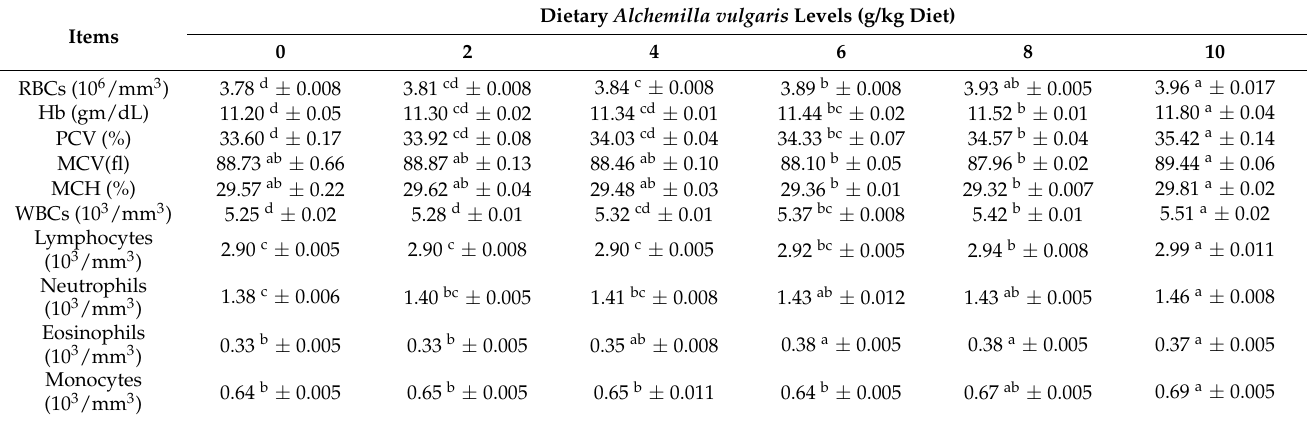
Table 3. Effect of Alchemilla vulgaris dietary supplementation on hematological indices of O. niloticus .